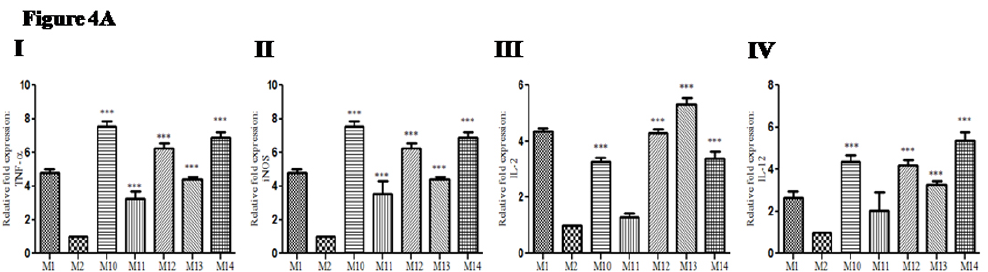
Fig. 4A. Change in pro-inflammatory cytokine(s) gene expression in infected mice upon adjunct therapy of recombinant cytokines (IL-17A and IFN- γ ) along with sub-optimal dose of AmpB: (I) Gene expression of TNF- a (II) Gene expression of iNOS(III) Gene expression of IL-2(IV) Gene expression of